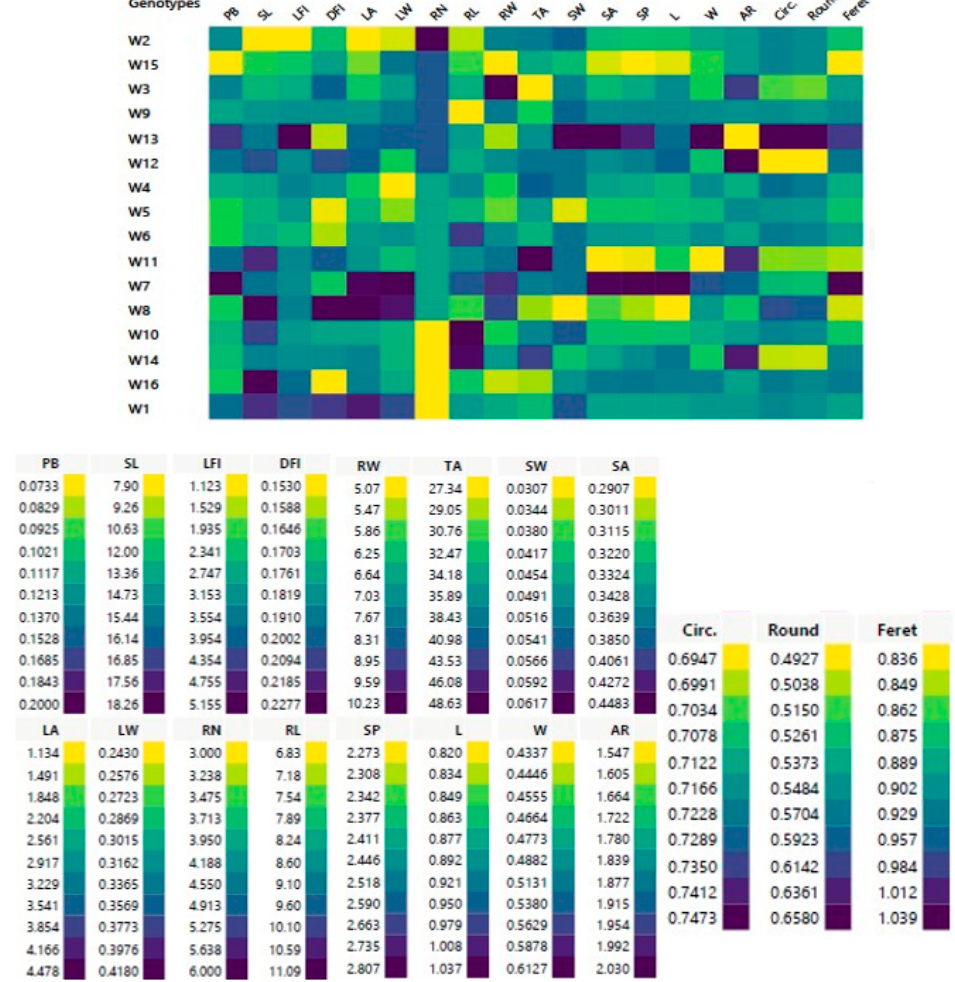
Figure 1. Cell plot of 19 morphometric traits of shoot, leaf, root and seed of 16 studied Egyptian T. aestivum genotypes. Data represents means of three replicates; PB = plant biomass (g); SL = shoot length (cm); LFI = length of first internodes (cm); DFI = diameter of first internode (cm); LA = leaf area (cm 2 ); LW = leaf width (cm) RN = root number; RL = root maximum length (cm); RW = root width (cm); TA = tip angle of root (°); SW = single seed weight; SA = seed area; SP = seed perimeter; L = length of seed major axis; W = length of seed minor axis; AR = aspect ratio; Circ. = circulatory; Round = roundness; Feret = Feret diameter.